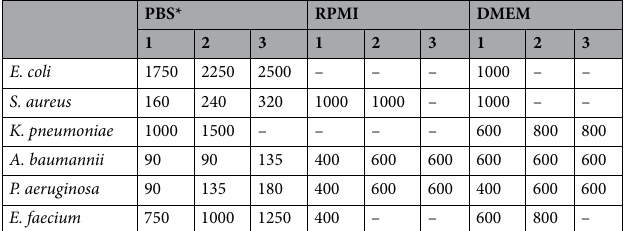
Table 3. Irradiation dose [J cm −2 ] per log reduction at 450 nm in comparison to the dark control. *Values derived from 26